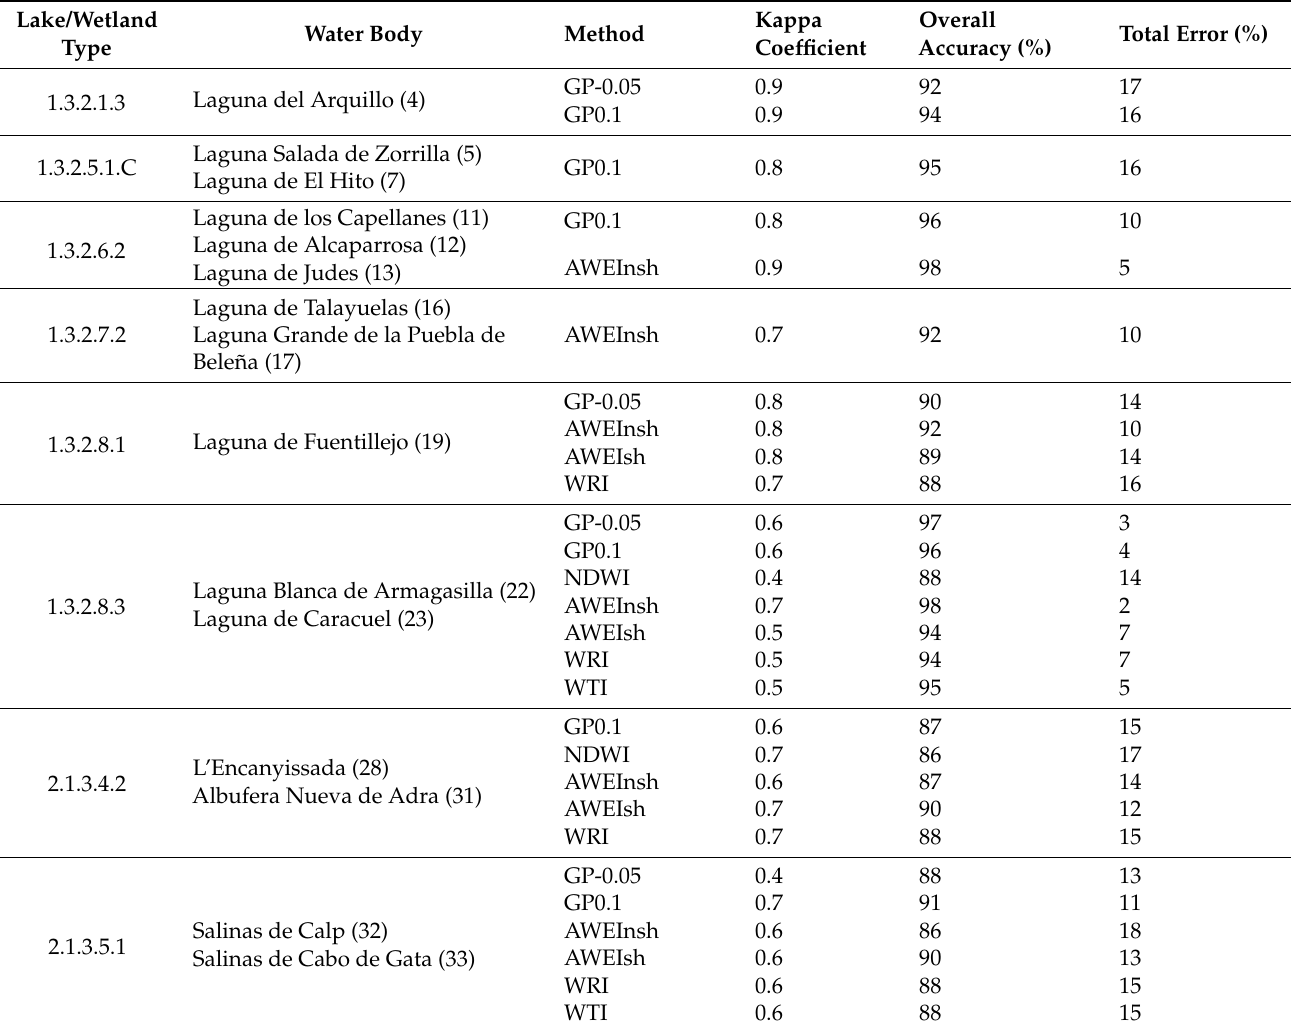
Table 4. Summary of accuracy assessments of the different water-cover estimation methods applied using Landsat-7 ETM+ imagery. Note that only those yielding total error (omission + commission) values lower than 20% are